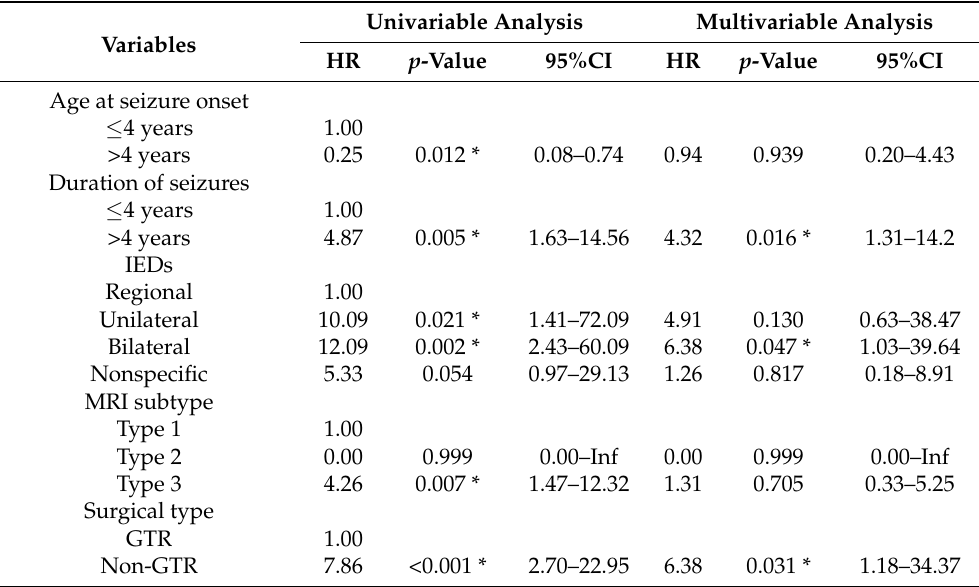
Table 2. Relative variables for seizure recurrence estimated with a Cox proportional hazards model on univariable and multivariable Cox regression analysis. Univariable Analysis Multivariable Analysis Variables HR p